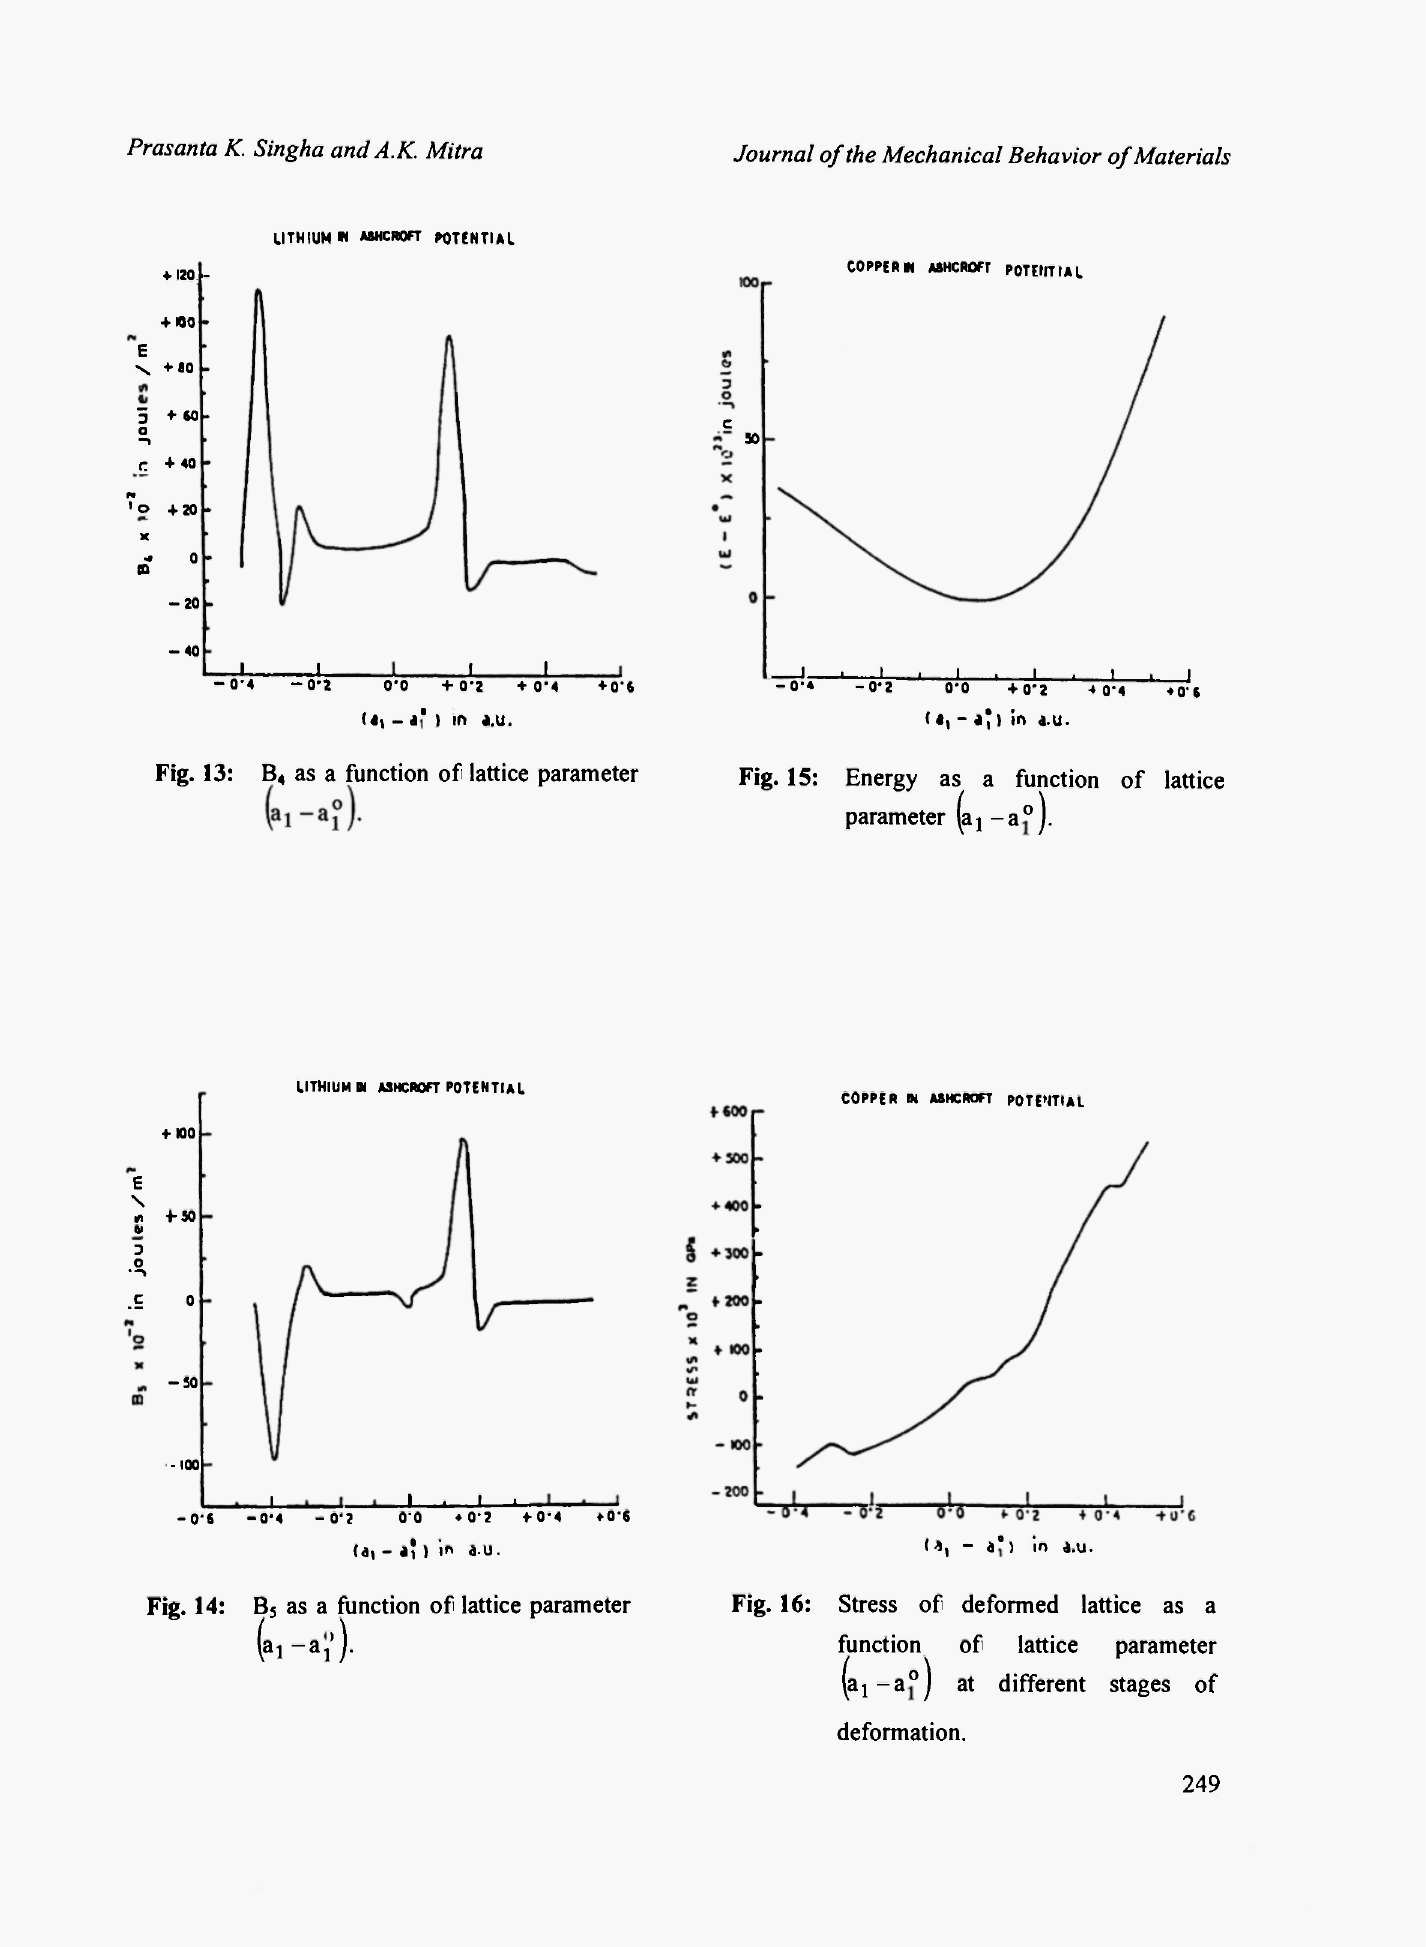
Fig. 14: B s as a function of lattice parameter